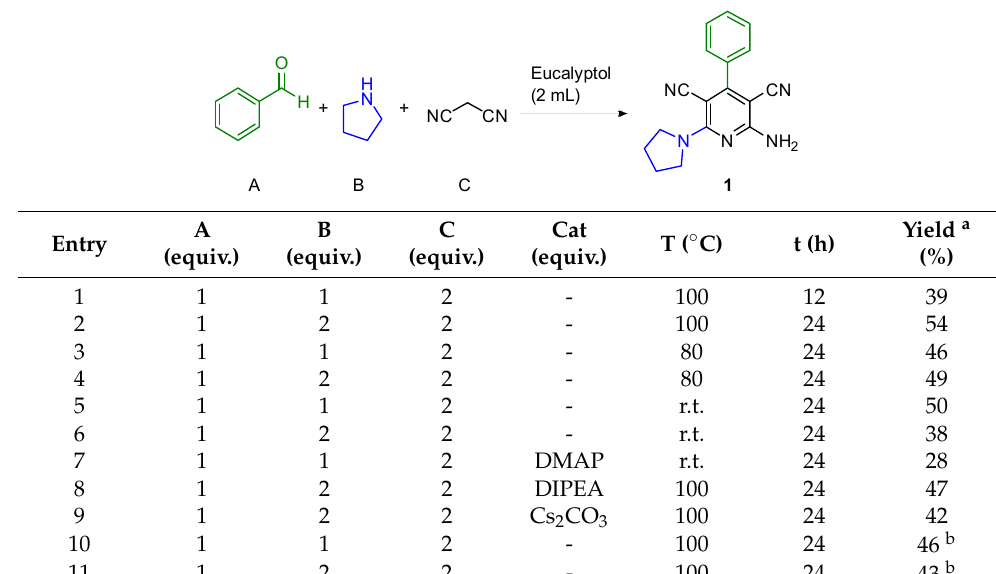
Table 1. Optimization of the multicomponent reaction.